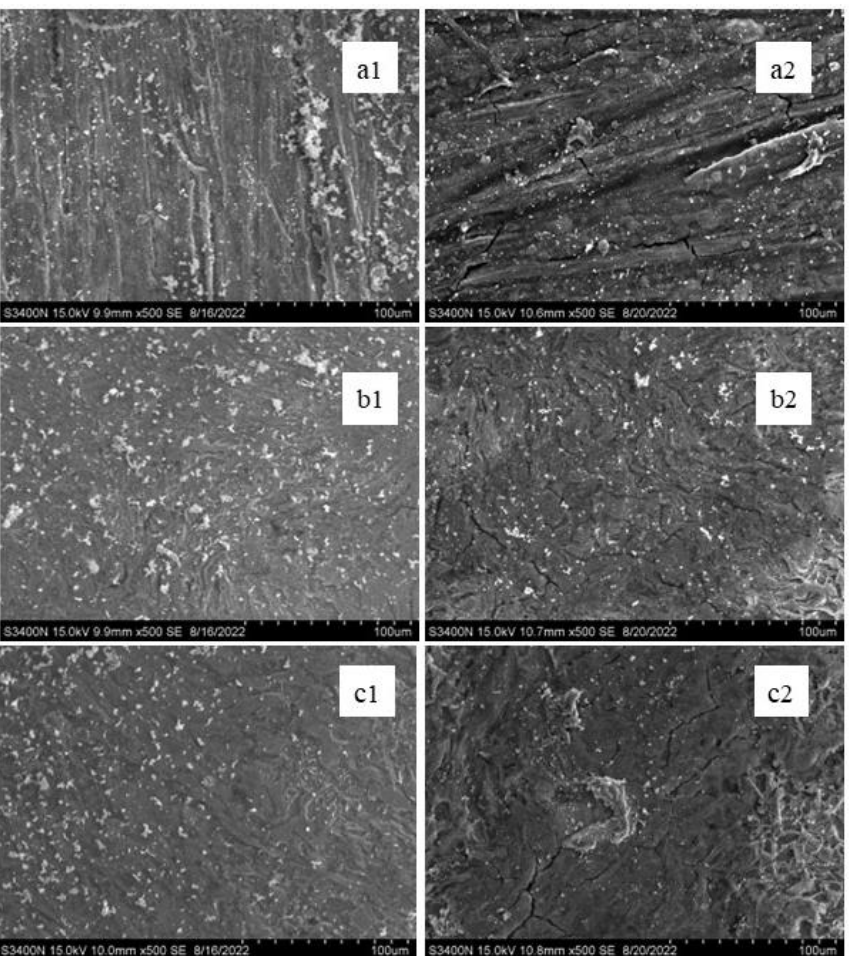
Figure 15. SEM macro-morphology characteristics of Q345B steel in 3.5 wt.% NaCl solution for 3 days: ( a1 ) un-USPed; ( b1 ) 200 s-2080 W-8 mm; ( c1 ) 200 s-2080 W-11 mm; for 3 days: ( a2 ) un-USPed; ( b2 ) 200 s-2080 W-8 mm; ( c2 ) 200 s-2080 W-11